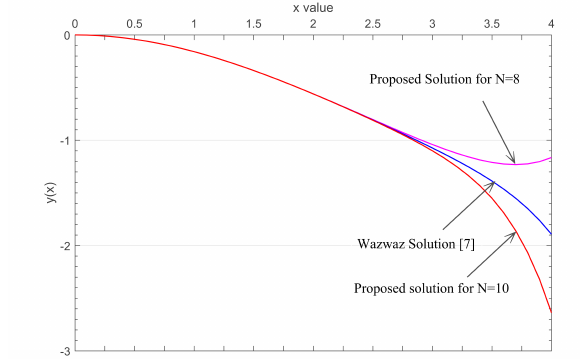
Fig. 6: Plot of obtained solution y(x) for N = 8, N = 10 and series solution presented by Wazwaz [7] for example 5.